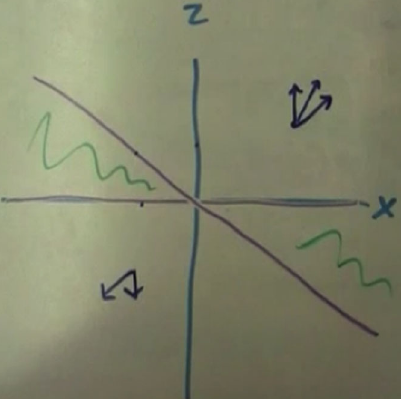
FIG. 5. Anne ’ s electric field vector map drawn while consid- ering the electric field in the two nonshaded regions defined by the charged sheets which are drawn in purple ink. At the top right, Anne has drawn arrows representing the electric field at a point due to each of the charged sheets and the net electric field. At the bottom left, she has only drawn arrows corresponding to the electric field at a point from each of the charged sheets.